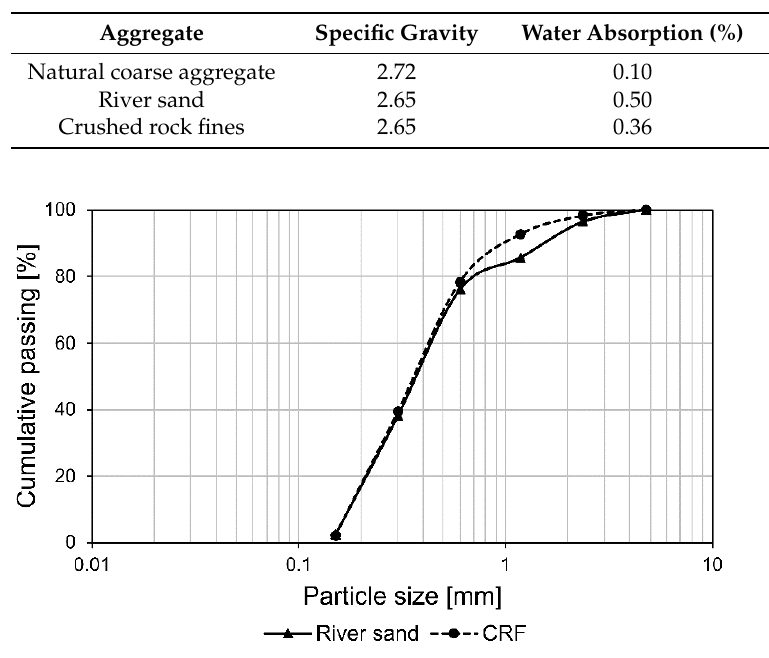
Figure 1. Grading curves of fine aggregates.